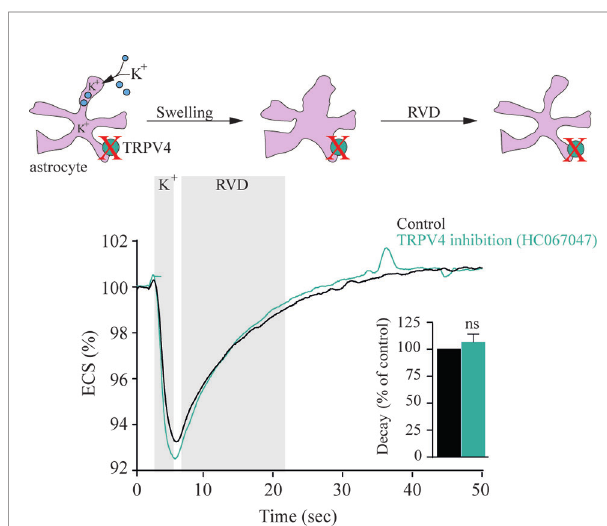
FIGURE 1 | TRPV4 does not modulate astrocytic regulatory volume decrease following activity evoked astrocyte volume dynamics. Electrical stimulation of acute hippocampal slices from rats results in neuronal activity associated with a [K + ] o transient that leads to a brief change in cell volume of nearby astrocytic structures without application of an osmotic gradient to the test solution. Graphs illustrate a representative recording and summarized volume decay rates of the activity-evoked extracellular space dynamics in the absence or presence of a TRPV4 inhibitor [1 µM HC067047, same results obtained with the less